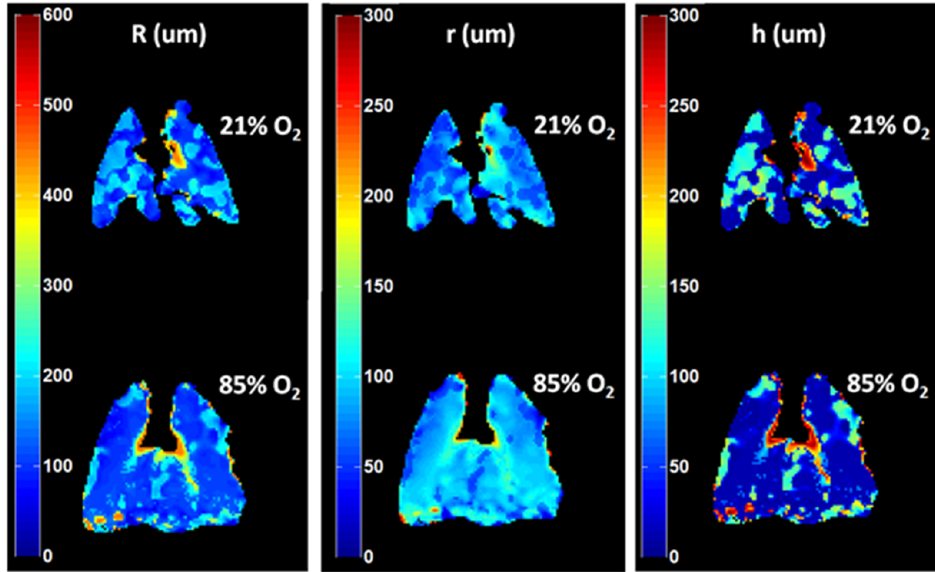
Figure 13. Probing diffusion in the lung parenchyma at multiple time scales allows extraction of several parameters describing microscopic lung structure. In this figure, reprinted with permission from Lindenmaier, 2022 (ref. [50]), alveolar diameter (R), terminal bronchiole radius (r-h) and alveolar depth (h) are separately extracted from six ADC measurements as per ref. [38]. A cohort exposed to hyperoxia (FiO2 = 0.85 for 48 h) experienced edema, inflammation and mild emphysematous remodeling, which was most readily visualized as an expansion of the terminal bronchioles.